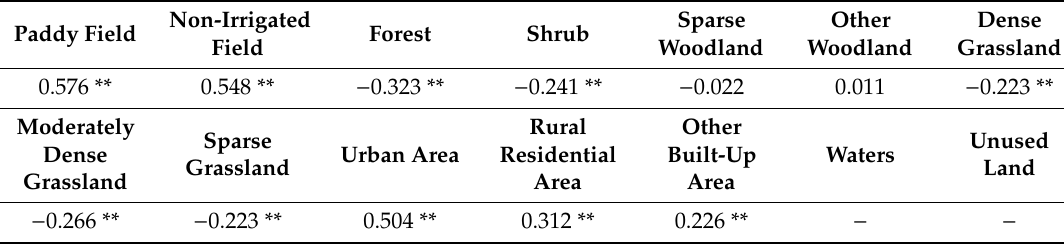
Table 2. The correlation coe ffi cient between land use sub-categories and the population.